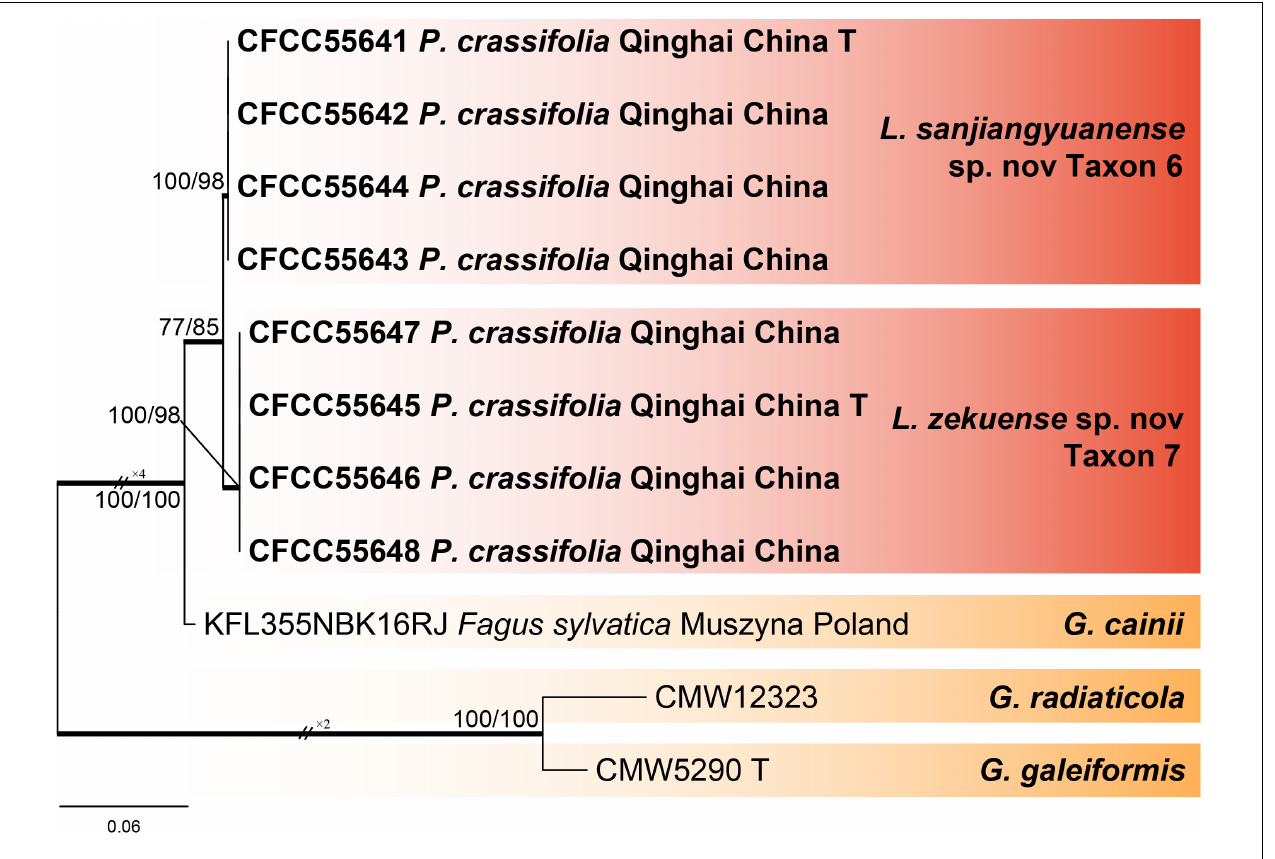
FIGURE 6 | Phylogram of G. cainii lineage (including taxons 6 and 7) based on combined (Tub2 + TEF1- α ) sequence data. Bold branches indicate posterior probability values ≥ 0.9. The MP/ML bootstrap support values ≥ 70% are recorded at the nodes. P ., Picea ; T, ex-type